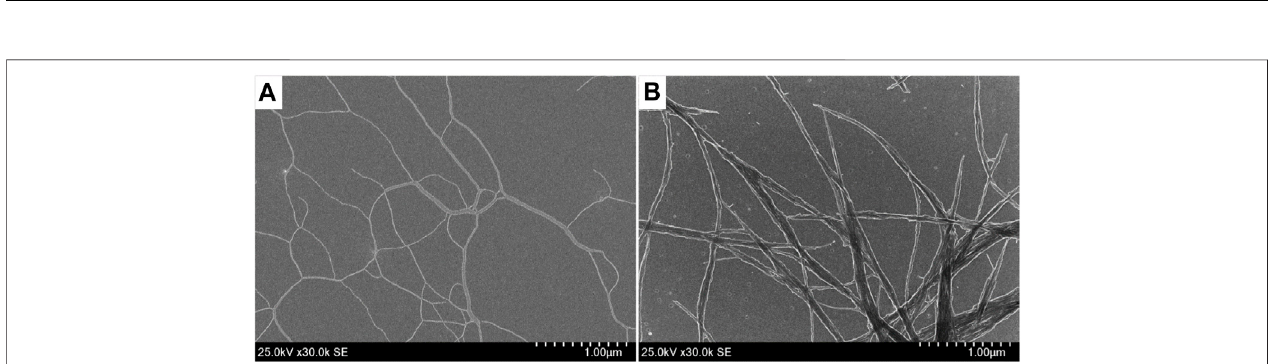
FIGURE2|(A) Absorptionand (B) fl uorescencespectraof( S )-Binaph-PDI(redlines)andBiph-PDI(bluelines)inchloroform(brokenlines)andinamixture(1:19)of chloroform/MCH (solid lines).